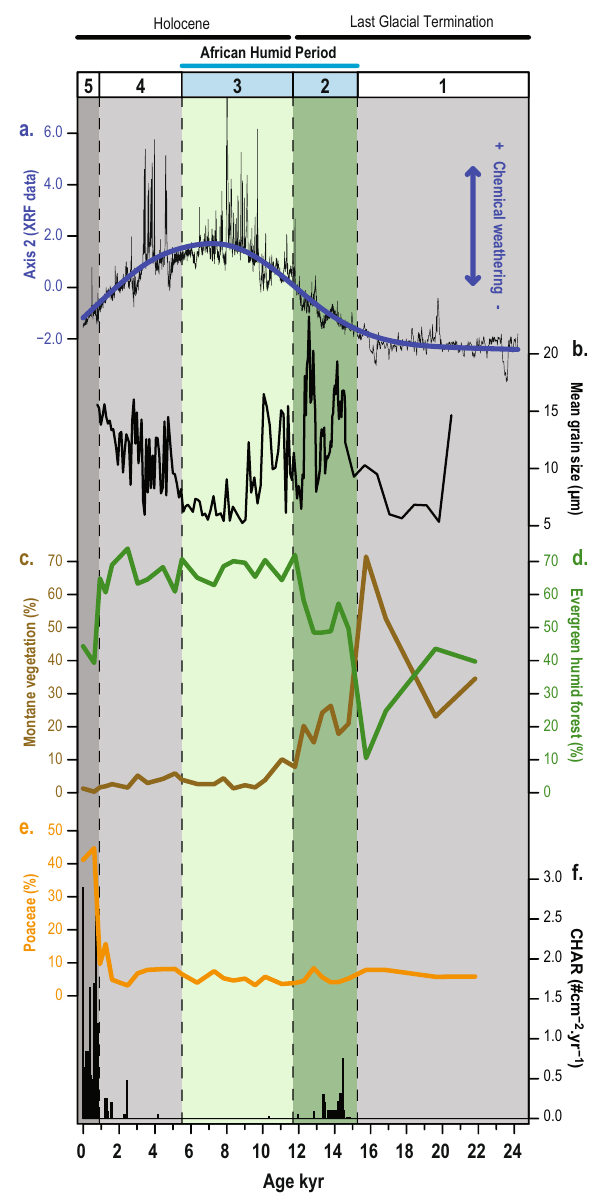
Fig. 2 Synthetic paleoenvironmental reconstructions obtained from the sediment core recovered in Lac Maudit. a Axis 2 of the Principal Component Analysis performed on the X-ray fl uorescence (XRF) scanning record, b mean-grain size measurements, c pollen sum of speci fi c taxa from montane vegetation (Ericaceae, Myrica , Podocarpus ), d pollen sum of speci fi c taxa from evergreen humid forest (Myrtaceae, Elaeocarpus , Macaranga-Mallotus , Acalypha , Weinmannia , Moraceae-Urticaceae, Celtis , Araliaceae, Trema , Ilex , Noronhia, and Pandanus ), e Poaceae pollen grains, and f in fl ux of charcoal particles (>160 µ m). The vertical bars represent the fi ve key periods of different paleoenvironmental conditions de fi ned in the